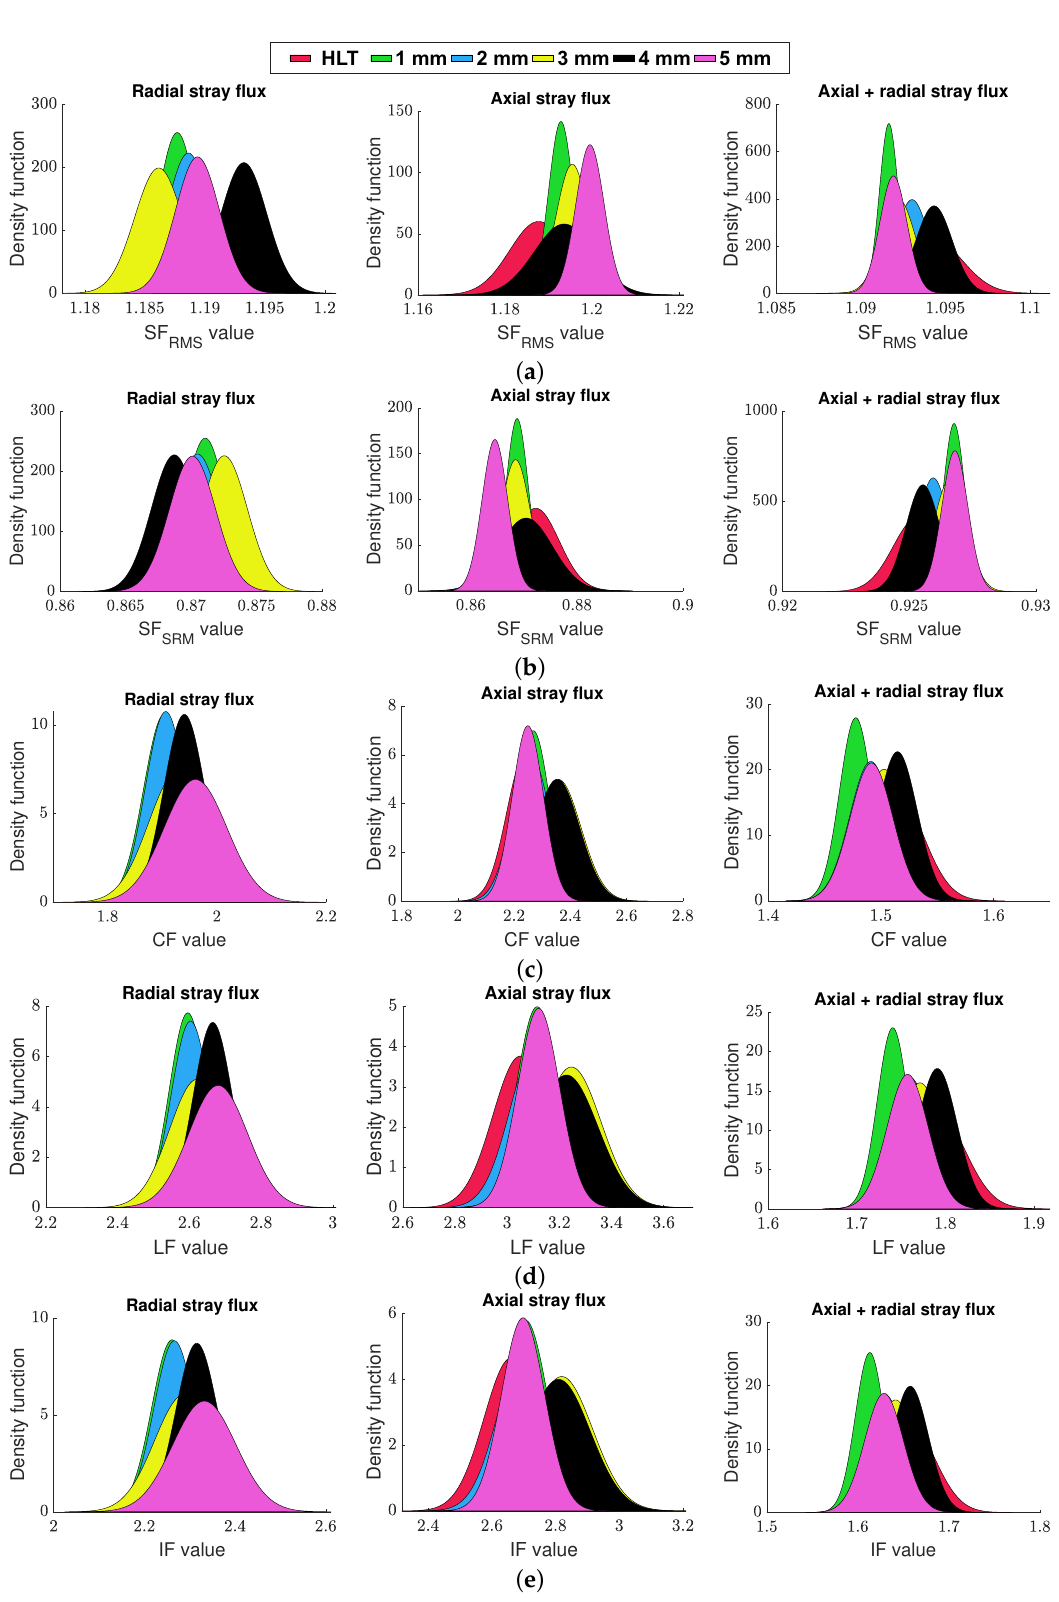
Figure 8. Normalized density functions defining detectability zones obtained by the different TF values from the different stray flux components using: ( a ) SF RMS value. ( b ) SF SRM value. ( c ) CF value. ( d ) LF value. ( e ) IF